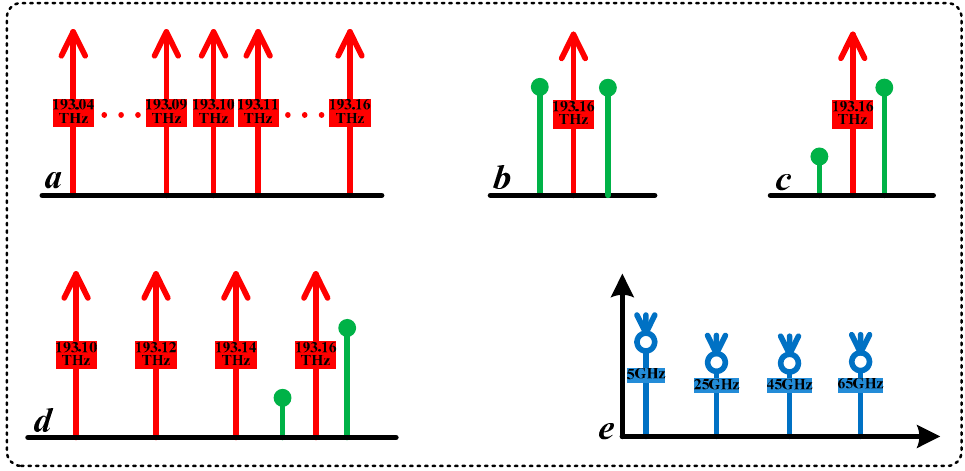
Figure 4. Schematic diagrams of spectra for key points. ( a ) spectrum of the optical comb, ( b ): spectrum of the modulated optical signal with 4QAM-OFDM, ( c ) spectrum of the modulated optical signal with pulse-shaped 4QAM-OFDM, ( d ) spectra of the coupled optical singals, ( e ) spectra of wireless multiple carrier.